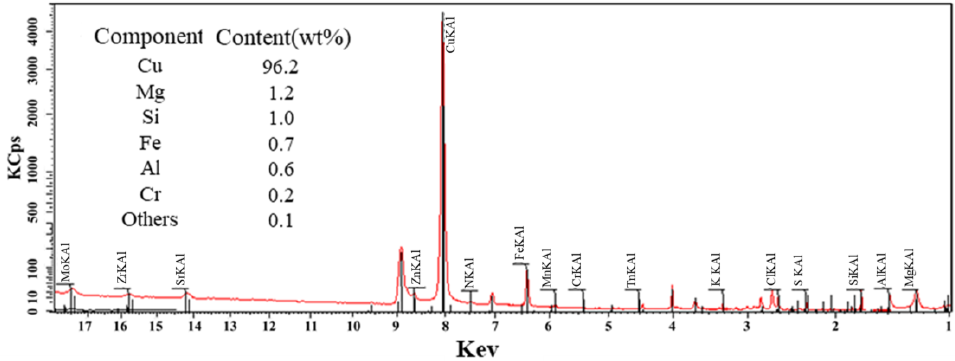
Figure 7. XRF analysis of OCCF sample.